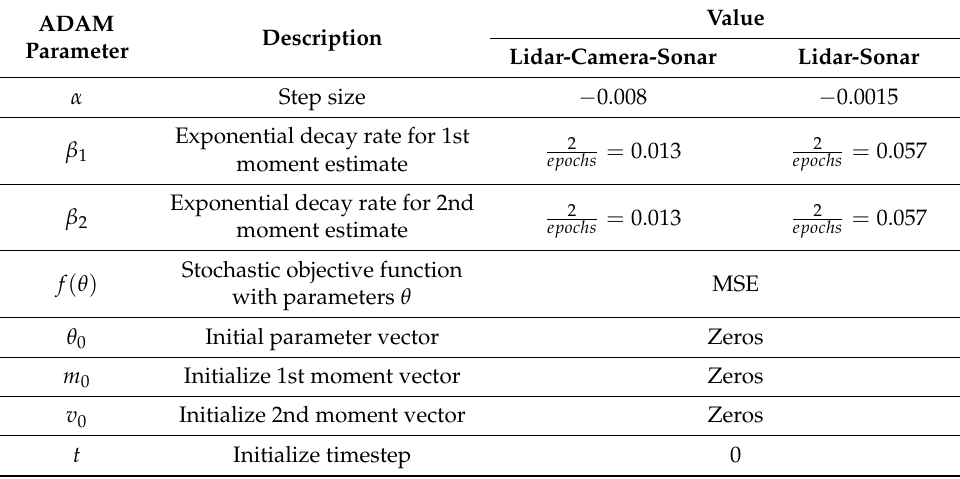
Table 4. Adam Configuration Parameters. ADAM Parameter